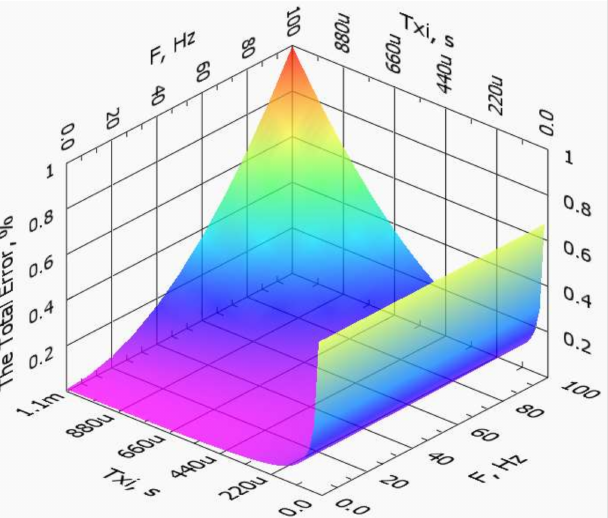
Figure 5. An example of the plot of the error of the conversion of information in the measurement channel with a frequency information